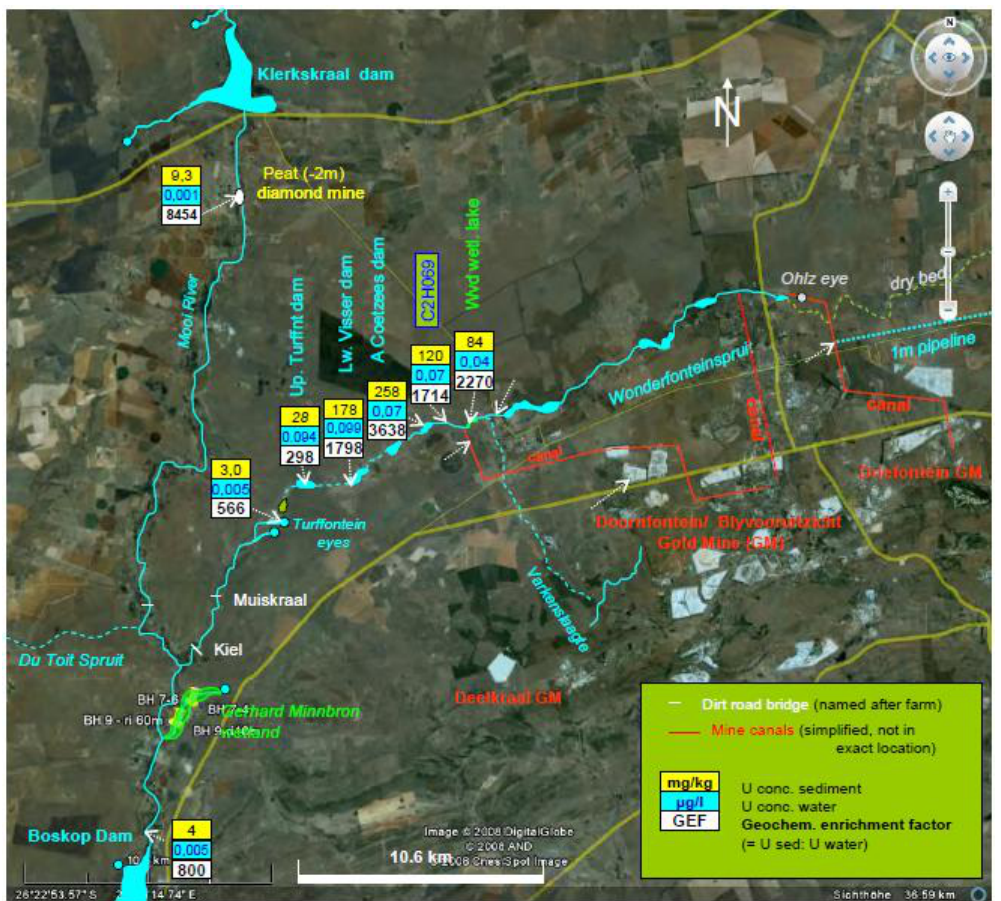
Figure 15. U concentrations and geochemical enrichment factors (GEF) for selected sediment-water systems in the lower Wonderfonteinspruit and upper Mooi River (map based on satellite image of the study area as retrieved from Google